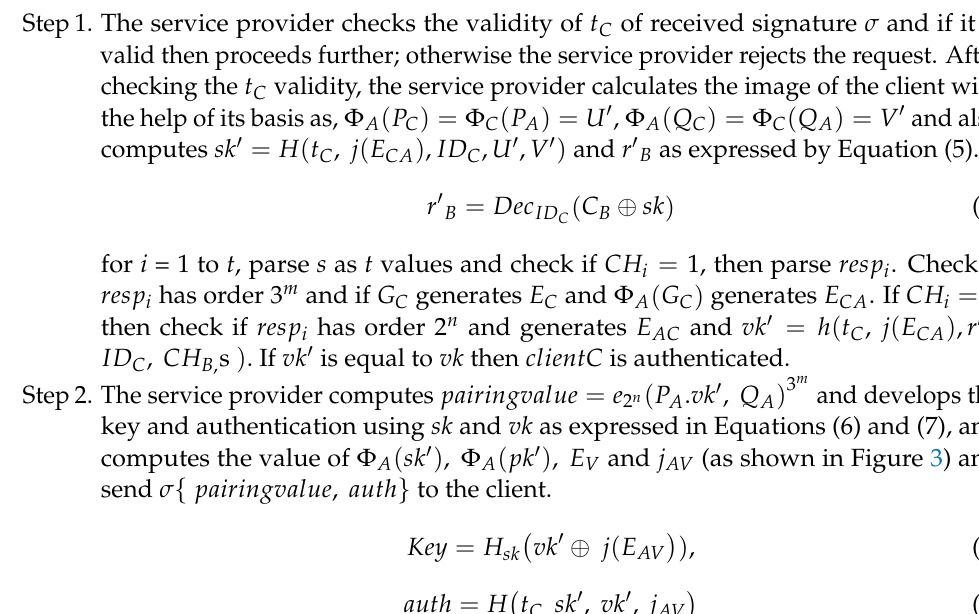
Figure 3. The work flow of client and service provider